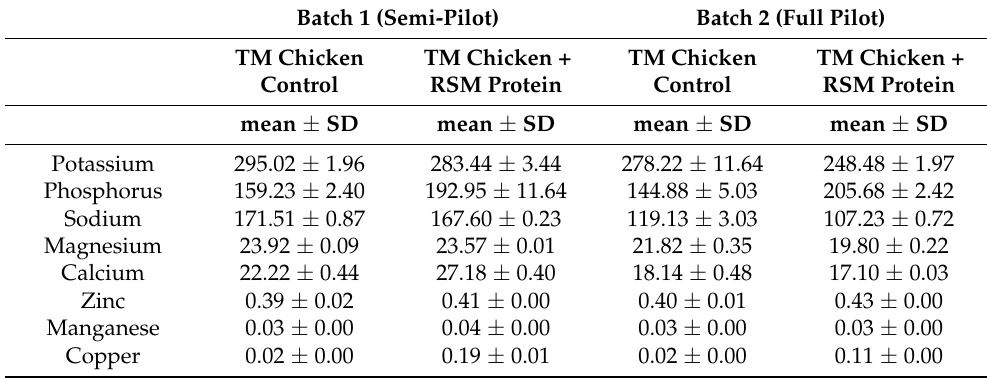
Table 8. Mineral and trace element contents of TM chicken breast: control and RSM-protein- supplemented (5% w/w ) samples. Values are expressed as mg per 100 g of fresh product.